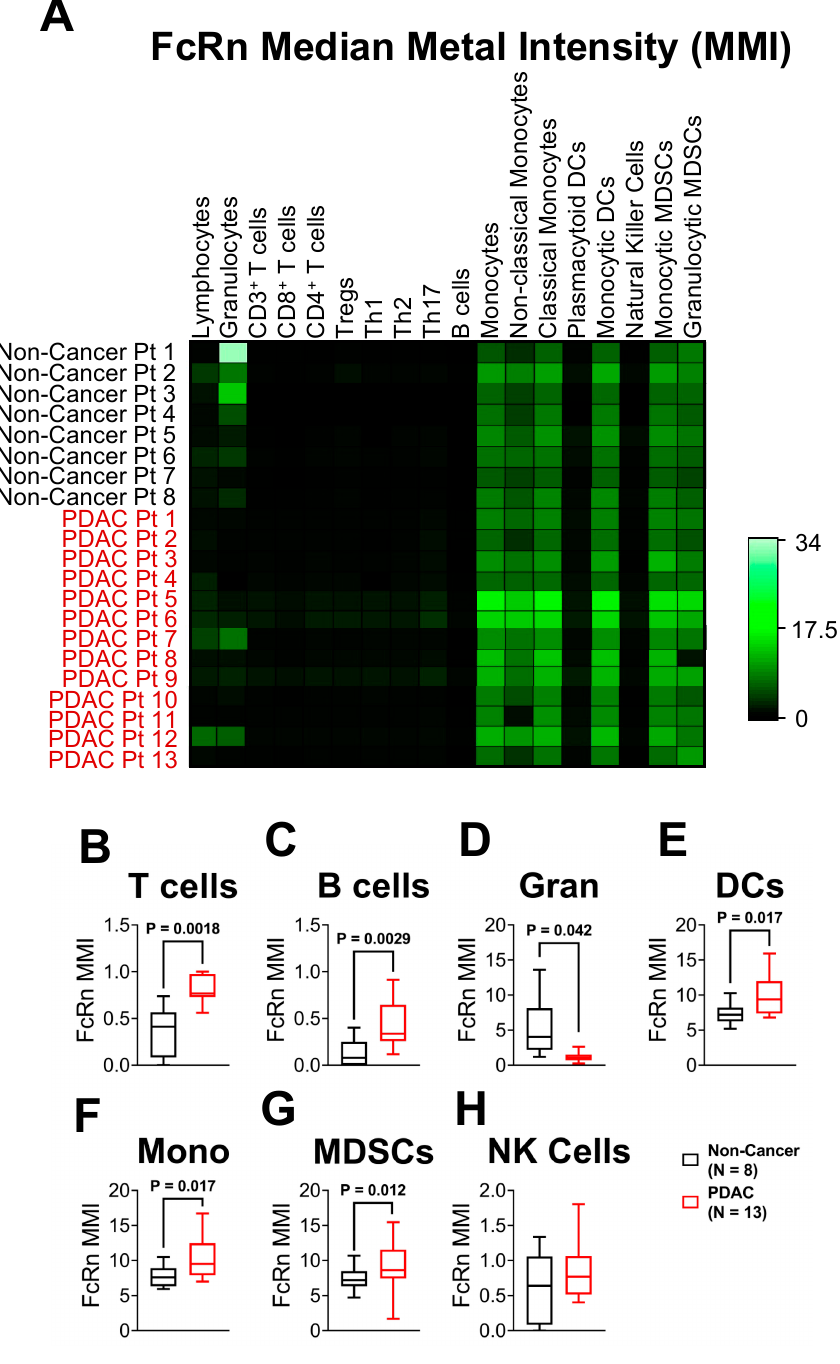
Figure 5. Myeloid FcRn Cellular Expression is Elevated in PDAC Patients. Per-cell expression of FcRn quantified by analyzing the mean metal intensity (MMI; non-cancer, n = 8; PDAC, n = 13) ( A ) All MMI values were normalized and provided in a representative heatmap for each individual sample. In addition to immune populations from Figure 3A, subsets of T cells, monocytes, dendritic cells and MDSCs are presented. Quantified MMI plots of non-cancer ( n = 8, black) and PDAC ( n = 13, red) ( B ) T cells, ( C ) B cells, ( D ) granulocytes, ( E ) dendritic cells ( F ) monocytes, ( G ) MDSCs, and ( H ) NK cells. Box and whisker plots represent the median and interquartile range (25–75%) with whiskers representing the outlying 25%. All statistical comparisons are unpaired t -tests with a Welch’s